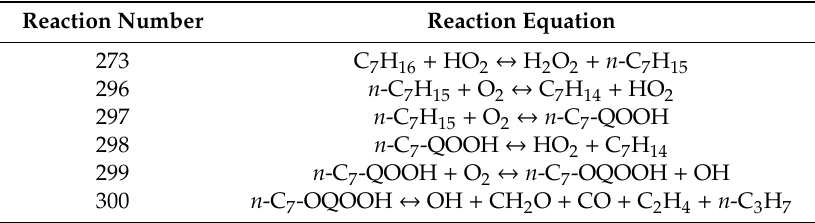
Table 2. Overview of the reactions with a high sensitivity value derived from the results shown in Figure 16.